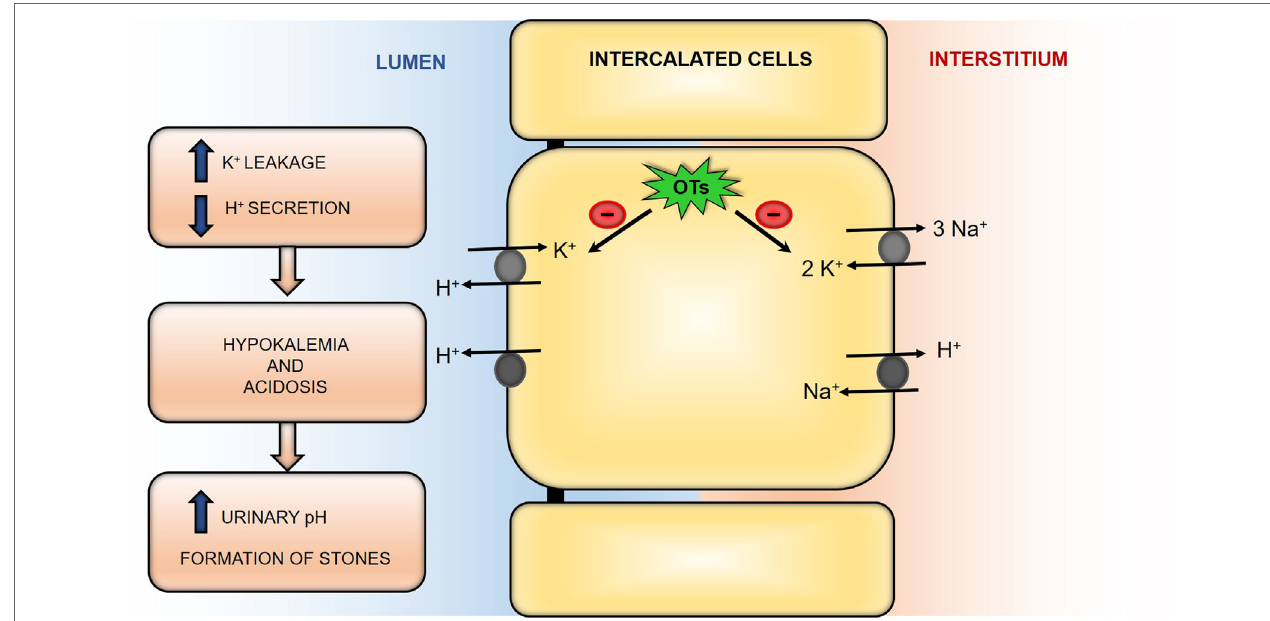
FiGURe 1 | Schematic representation of organotin compounds (OTs) effects in renal intercalated cells in mammalian models. OTs are able to inhibit both H + / K + -ATPase and Na + /K + -ATPase activities. This inhibition leads to hypokalemia and acidosis. Former is due to increased K + leakage to the lumen, and latter is due to decreased H + secretion. In consequence, urinary pH is increased, which is a known factor for formation of kidney